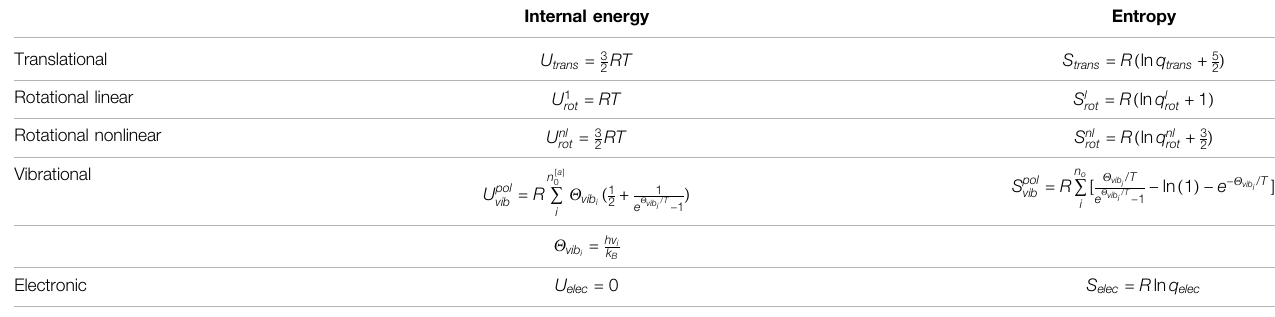
TABLE 2 | Contributions to internal energy and entropy.